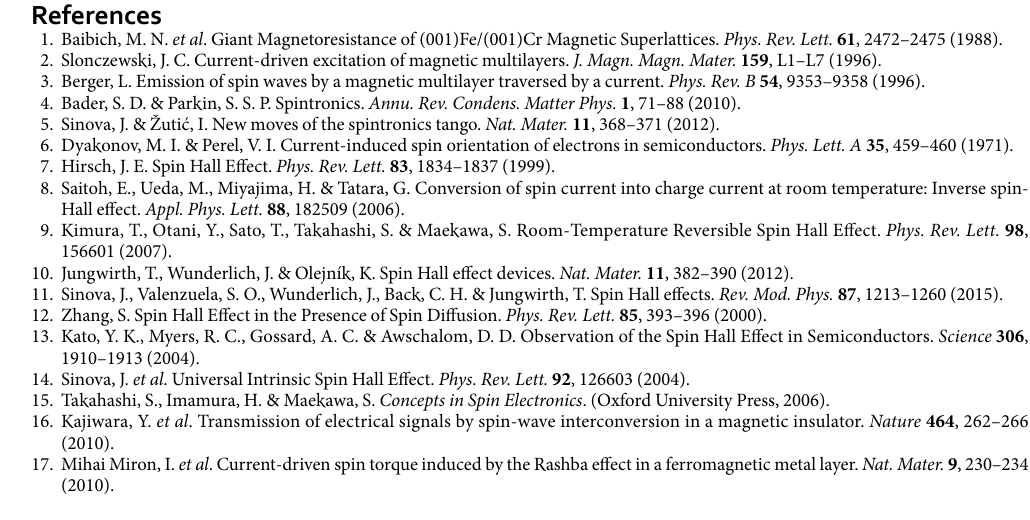
The dependence of the effective spin mixing conductance on the system parameters (such as insulating gap, s-d coupling, and layer thickness) as well as the relations between the real part and the imaginary part of the effective spin mixing conductance are studied.